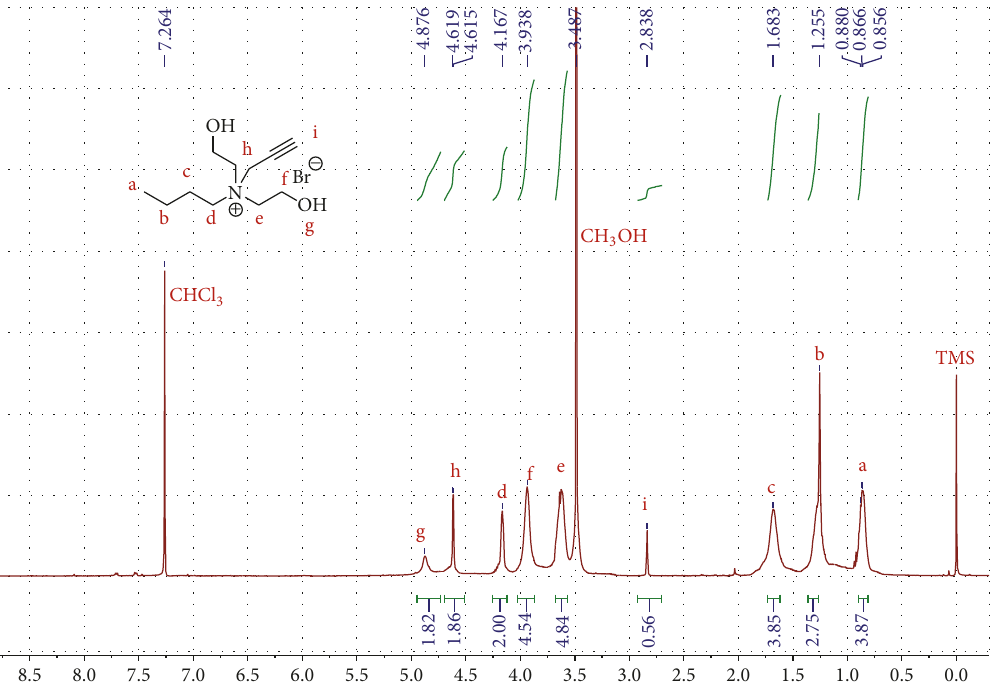
Figure 1: 1 H NMR spectrum of 2a